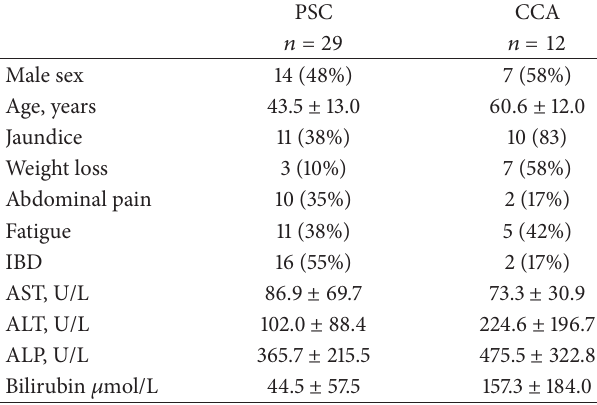
Table 1: Clinical characteristics and laboratory values of patient populations